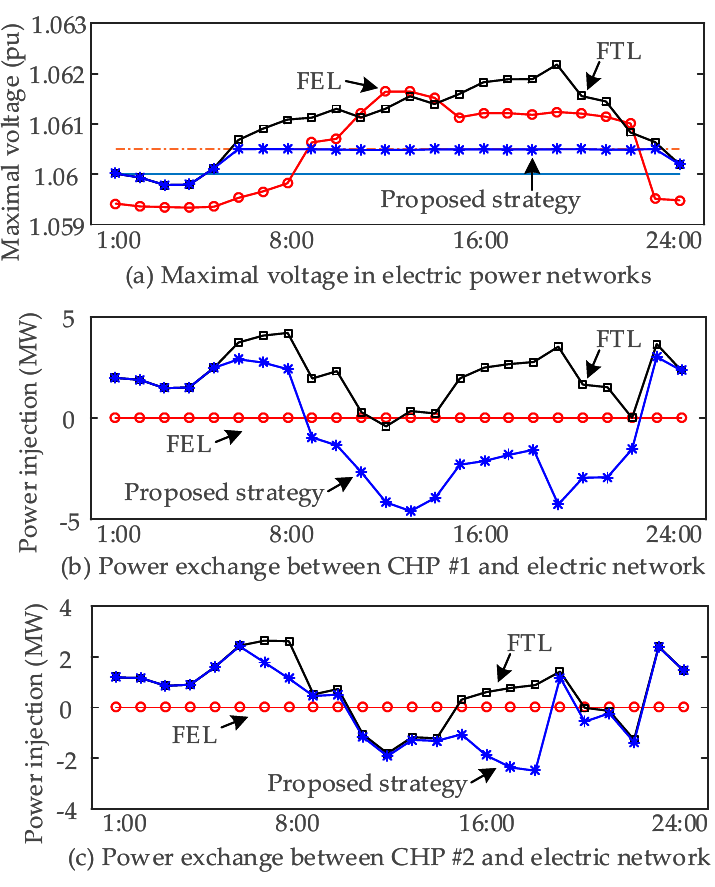
Figure 13. Control performance on the power electric networks (( a ) Maximal voltage in electric power networks ( b ) Power exchange between CHP #1 and electric network ( c ) Power exchange between CHP #2 and electric network).